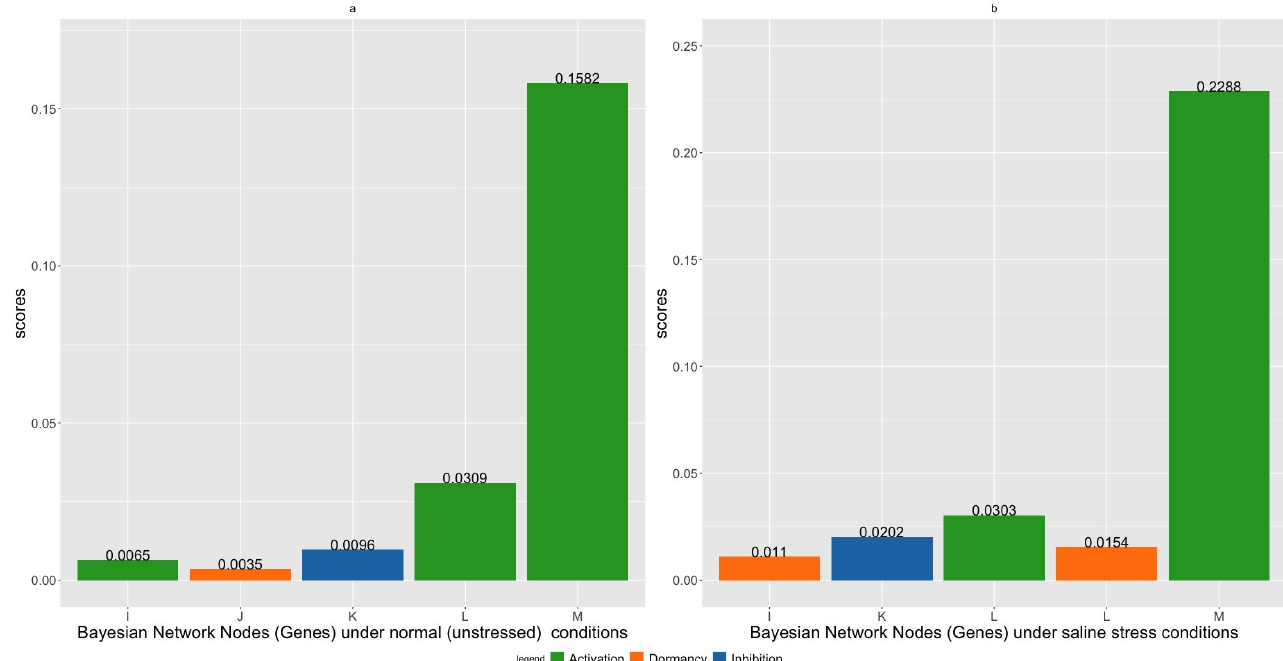
Figure 8. Single node intervention under ( a ) normal and ( b ) saline stress conditions.